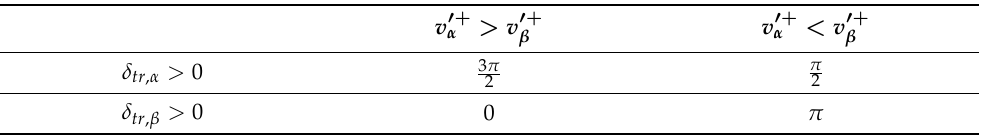
Table 1. Zero-cross detection: angle reset